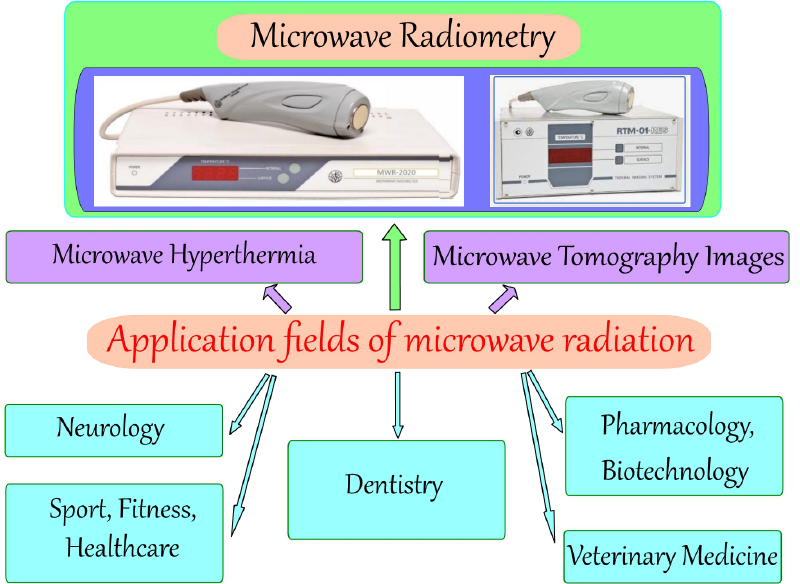
Figure 1. Some applications of microwave radiation in